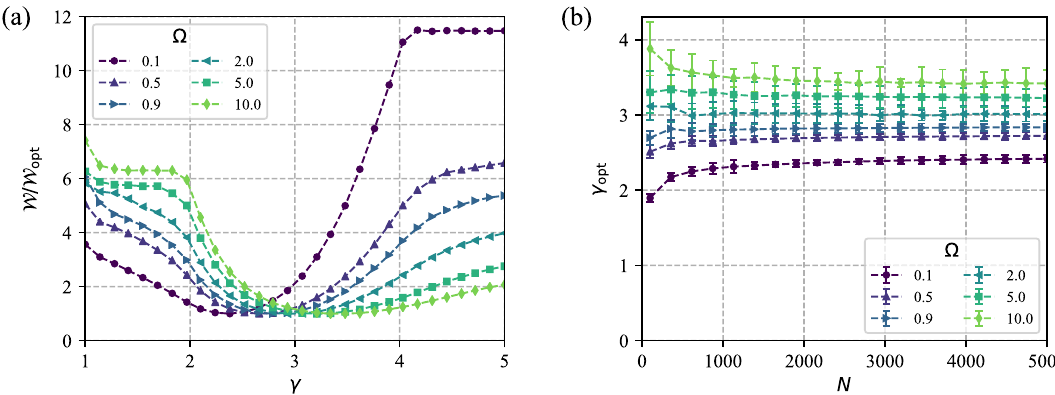
Figure 8. ( a ) A well defined global minimum in total power cost means that the optimal bifurcation exponent γ opt can be determined without ambiguity. The figure shows the total power cost as a function of bifurcation exponent, γ , for several values of (cid:31) . ( b ) The relationship of γ opt to N and (cid:31) , numerically determined using SALVO, is qualitatively similar to the relationship determined from analytic expressions. The figure shows γ opt vs N for several (cid:31) . Error bars represent uncertainty in the fit to the bottom of the minimum.